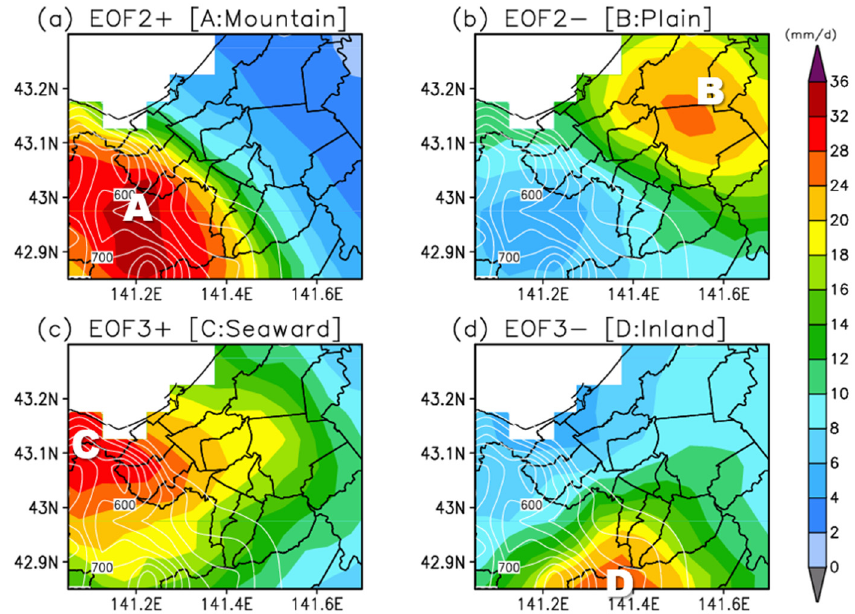
Figure 7. Distribution of precipitation composites for each type (unit: mm/day). ( a ) mountain, ( b ) plain, ( c ) seaward, and ( d ) inland types. White contours indicate orography, and black lines indicate administrative boundaries. The marks “A”,”B”,”C”, and “D” are the locations based on Figure 6.